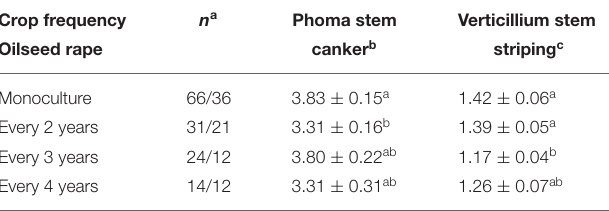
TABLE 4 | Long-term effects of crop rotation on severity of Phoma stem canker and Verticillium stem striping. Crop frequency n a Phoma stem Verticillium stem Oilseed rape canker b striping